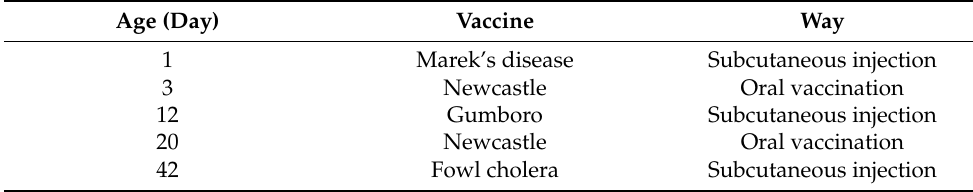
Table 2. Vaccination